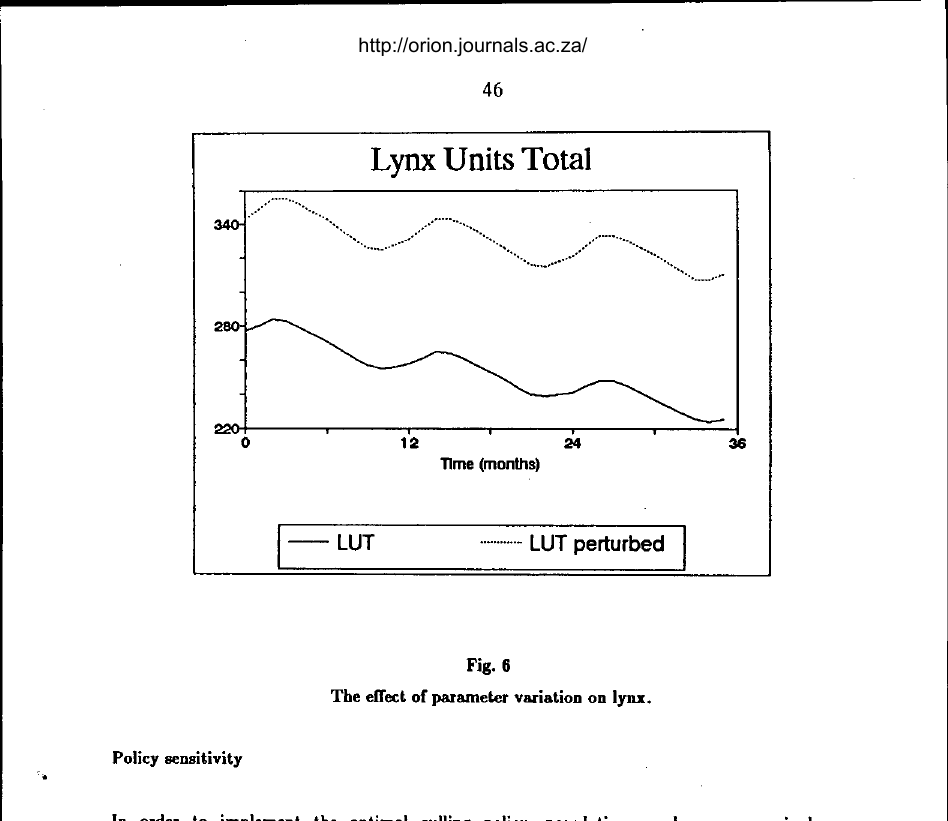
Fig. 6 The effect of parameter variation on